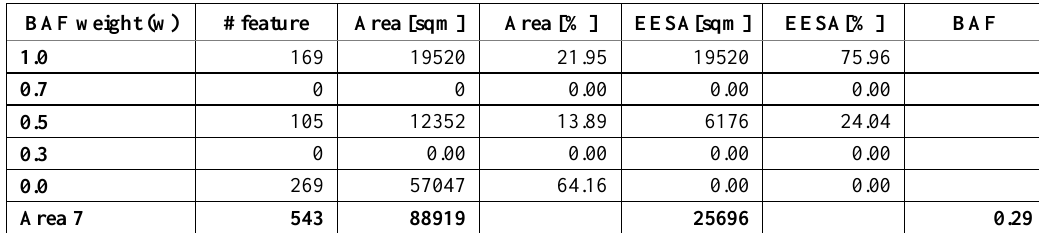
Table 5. BAF calculation for test area